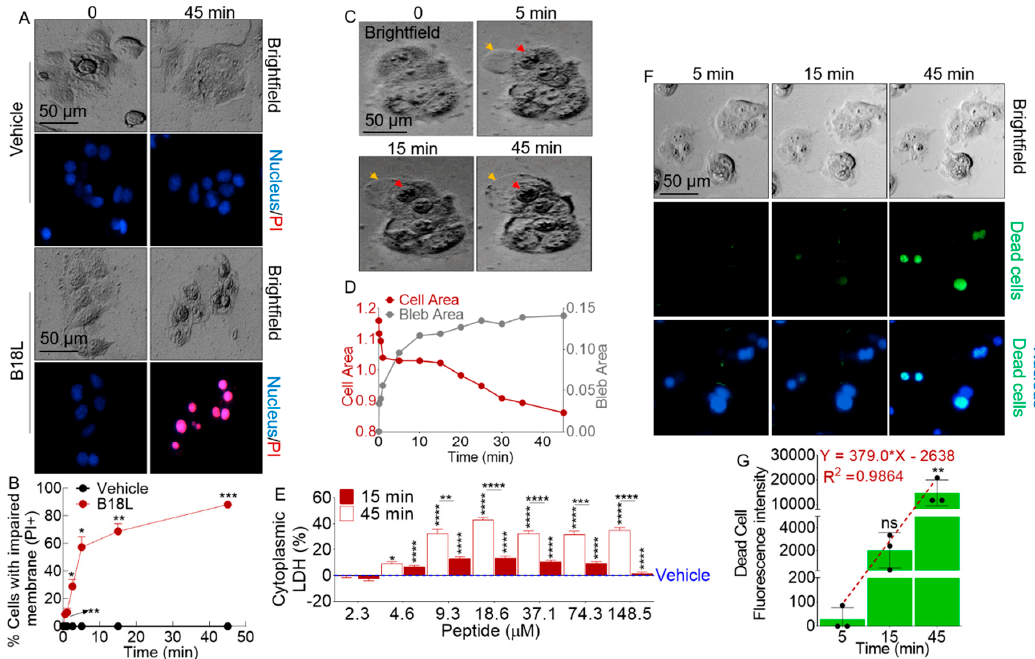
Figure 6. Membranolytic effects of B18L: ( A ) DAPI/PI staining of MCF7-G11-TR5 treated with vehicle or B18L at 0 and 45 min. Fluorescence images were manually obtained at 10× using the Lionheart FX automated microscope. Scale bar: 50 µm. ( B ) Quantification of cells with impaired membrane at 0.5, 1, 2.5, 5, 15, 45 min. Five 10× fields of view were analyzed per time point. Two-tailed Welch’s t test was used to compare the difference between vehicle and B18L at each concentration. *** p < 0.005, ** p < 0.01, * p < 0.05 and nonsignificant was not shown for clarity. ( C ) Representative live cell images of membrane blebs captured at 0, 5, 15, and 45 min. 10× kinetic images were acquired using the Lionheart FX automated microscope. Orange arrows indicate membrane blebs and red arrows indicate the nucleus of blebbing cells. Scale bar: 50 µm. ( D ) Quantification of area of the cell versus area of the bleb as a function of time. ( E ) LDH leakage assessed in the supernatant of MCF7-G11-TR5 cells treated with various concentrations of vehicle or B18L after 15 min or 45 min treatment. Two-tailed Welch’s t test was used to compare the difference between vehicle and B18L at each concentration. Ordinary one-way ANOVA test (Dunnett’s correction) was used to determine the differences between the treated groups as compared to vehicle treatment. **** p < 0.001, *** p < 0.005, ** p < 0.01, * p < 0.05 and nonsignificant was not shown for clarity. ( F ) Representative live/dead cell stain images of vehicle and B18L treated cells revealing free amines (green florescence) and nucleus (blue fluorescence). 10× kinetic images were taken using the Lionheart FX automated microscope. Scale bar: 50 µm. ( G ) Quantification of dead cell fluorescence intensity at different time points. The fitted linear equation and R-square value were obtained by GraphPad Prism analysis. Error bars represent SEM of at least three replicates. Ordinary one-way ANOVA test (Dunnett’s correction) was used to determine the differences between the treated groups as compared to vehicle treatment. ** p < 0.01 and ns = not significant. Experiment was repeated at least three times, with similar results.